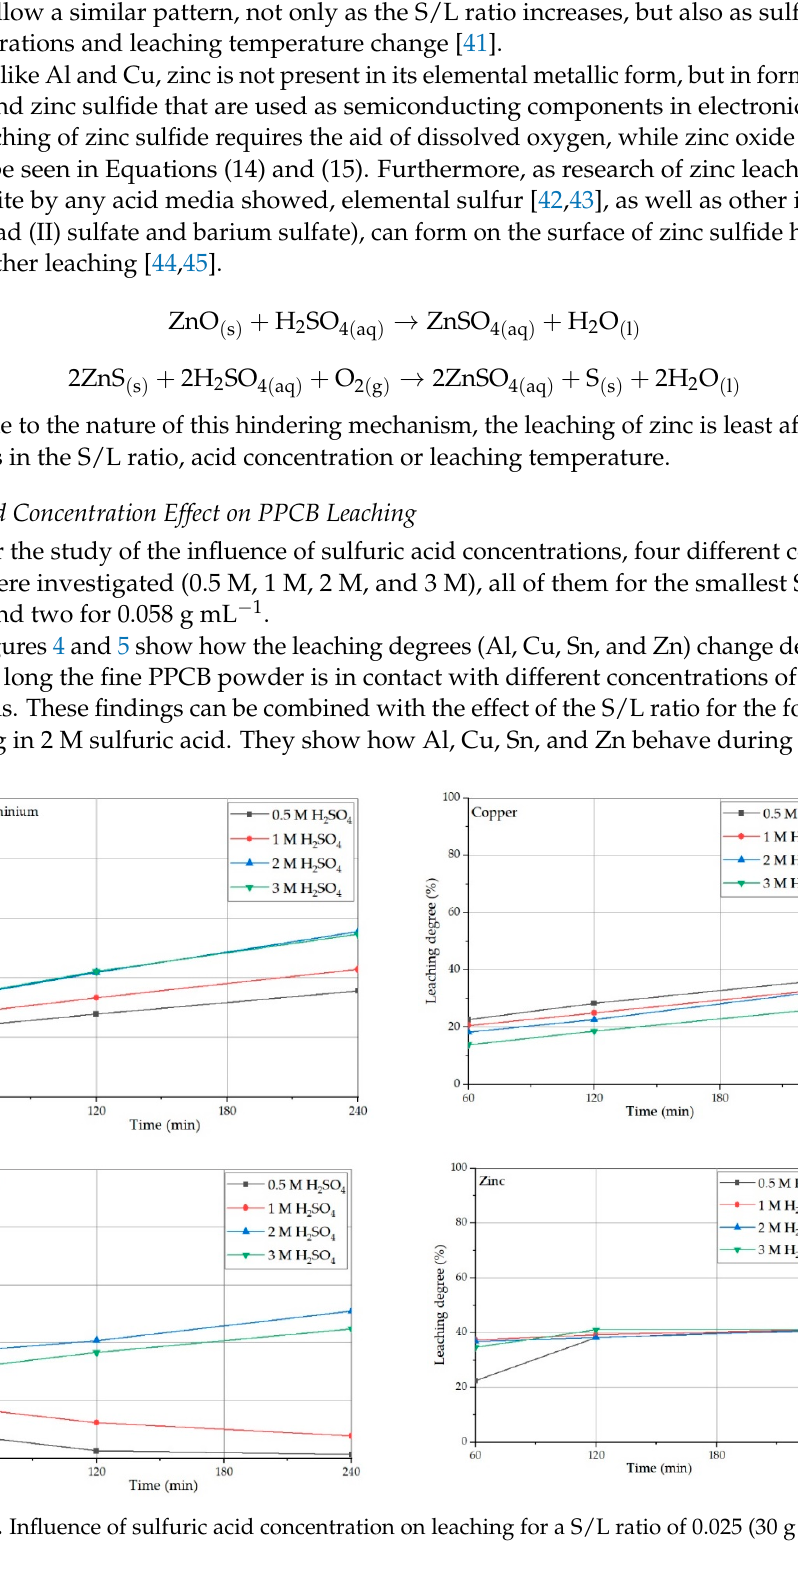
Figure 5. Influence of sulfuric acid concentration on leaching for a S/L ratio of 0.058 (70 g of PPCB).